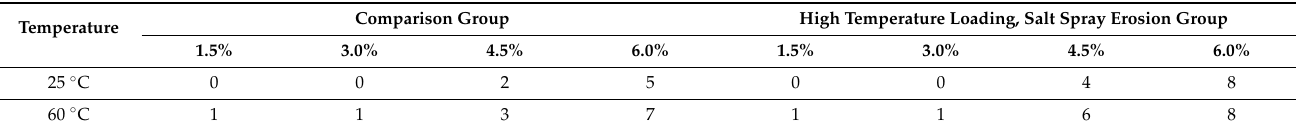
Figure 8. Drawing fracture surface of composite structure specimen: ( a ) Disconnection inside the mixture ( b ) Disconnection at the interface between the adhesive layer and the mixture. Table 3. The number of interface disconnections between the bonding layer and the mixture of the composite structure specimens under different working